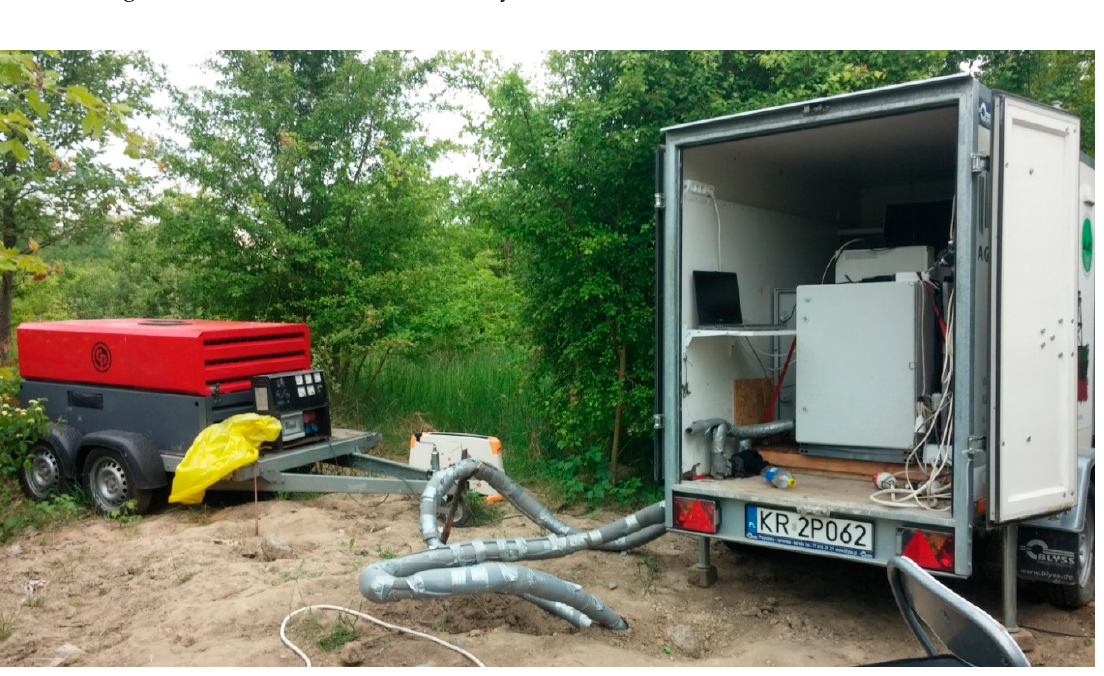
Figure 5. Modules of the TRT apparatus together with a power generator (corresponds to Figure 1).